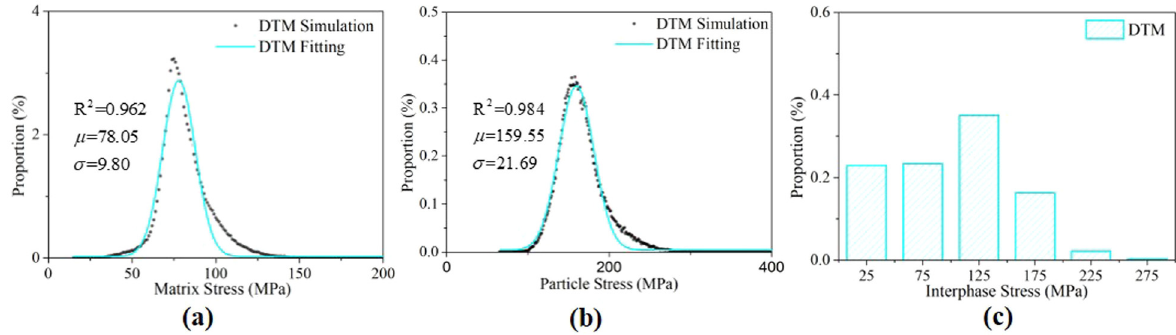
Figure 14: Micro - stress distribution with DTM nanoparticles at 0.1% strain: ( a ) matrix, ( b ) particle, and ( c )